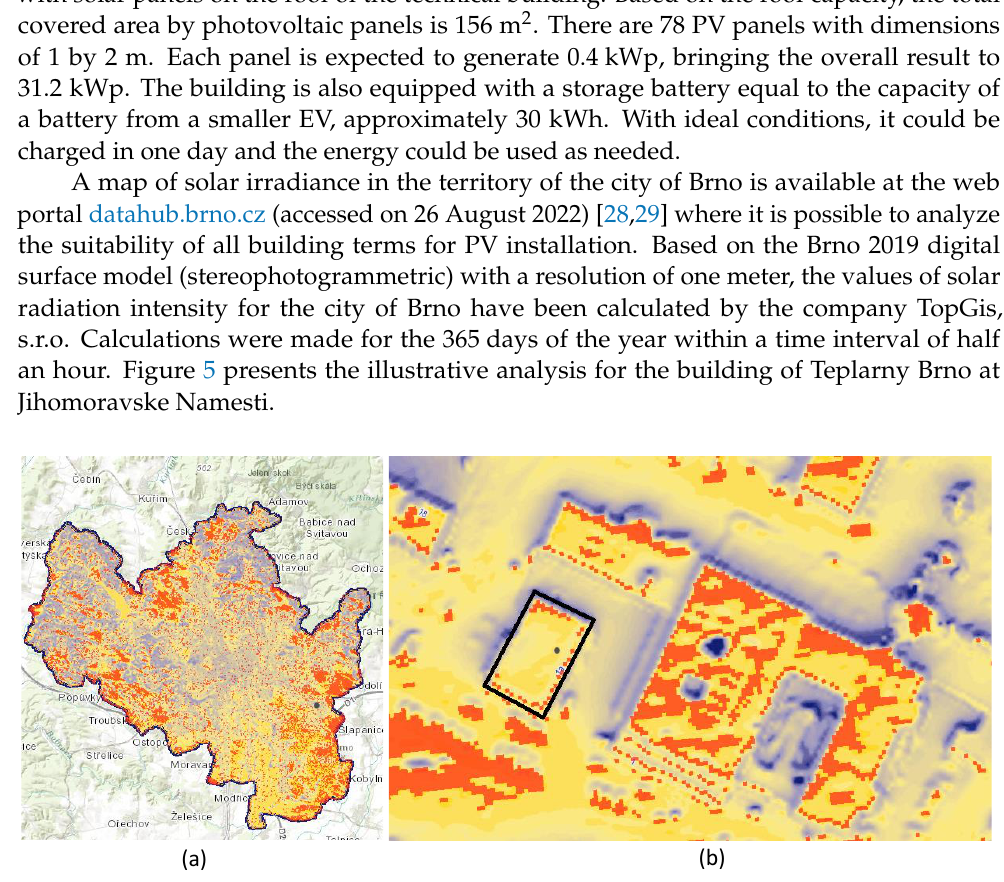
Figure 5. Maps of solar irradiance, ( a ) area of Brno and ( b ) zoom to address Jihomoravske Namesti 1136/1a